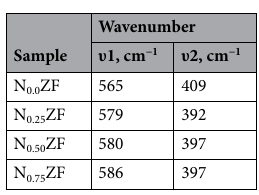
Table 6. The effect Ni ratio on the wavenumber of ʋ 1 and ʋ 2 bands.